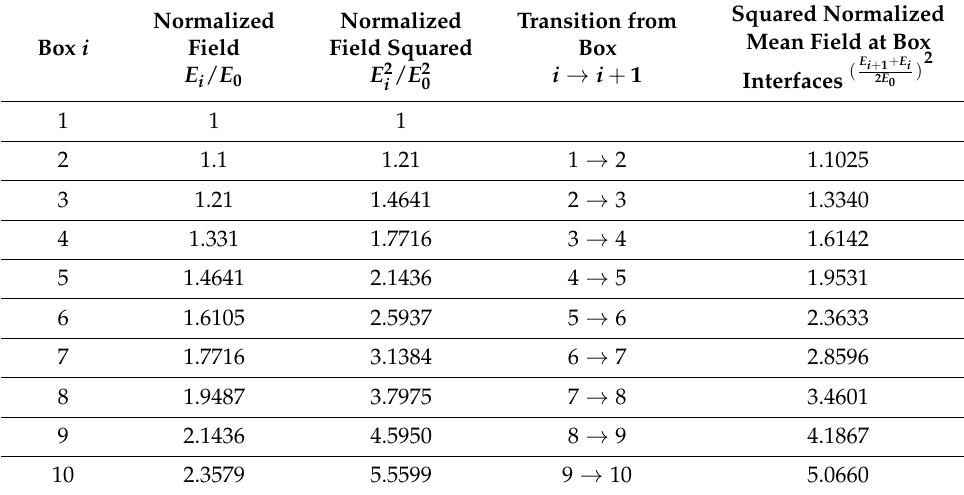
Table 1. Field values used in the calculations.